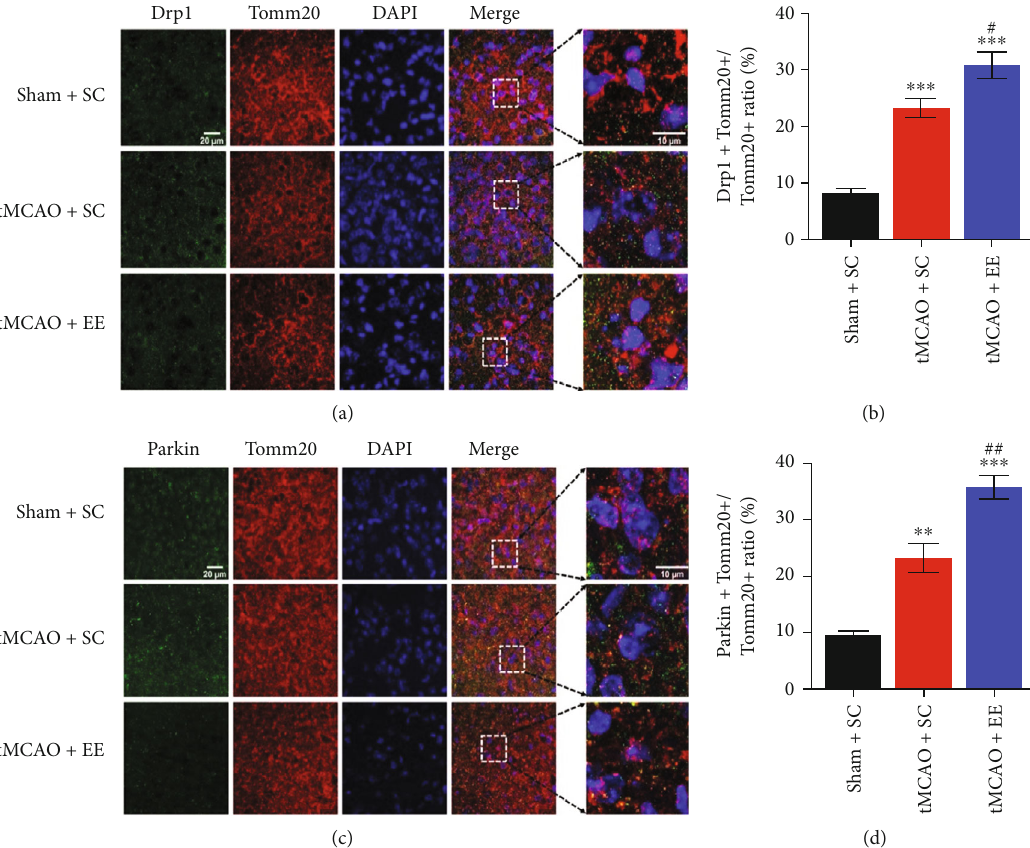
Figure 8: (a) The results of Drp1+Tomm20 costaining. (b) Comparison of the proportion of Drp1-positive mitochondria. (c) The results of Parkin+Tomm20 costaining. (d) Comparison of the proportion of Parkin-positive mitochondria. ∗∗ P < 0 : 01 and ∗∗∗ P < 0 : 001 vs . sham+SC group; # P < 0 : 05 and ## P < 0 : 01 vs . tMCAO+SC